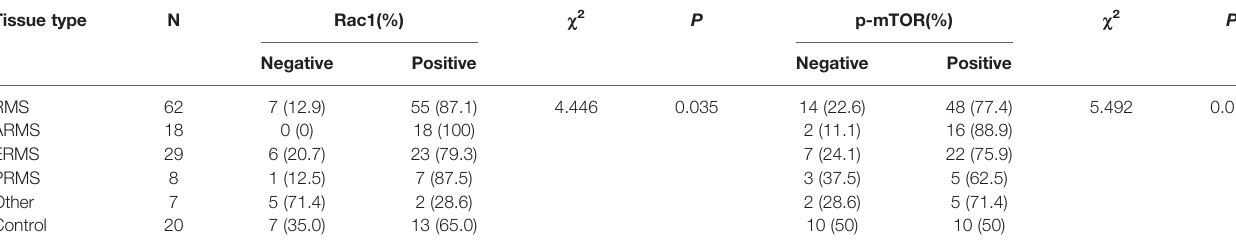
Others represent nonspeci fi c types of RMS. Control represents normal muscle tissue.